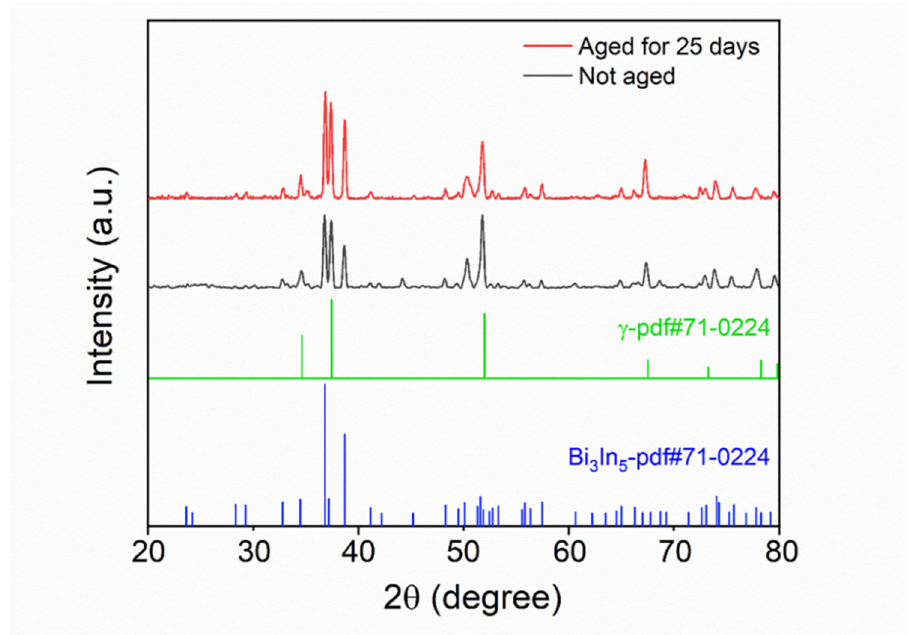
Figure 14. XRD analysis results of the mixed solder joint before and after aging for 25 days.